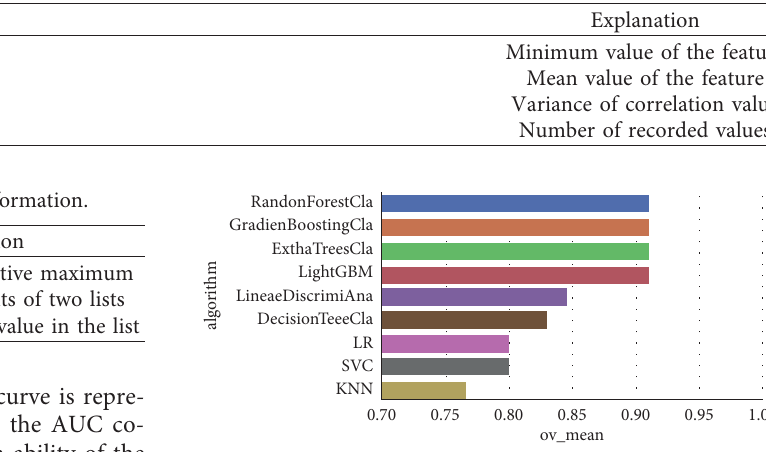
Figure 3: Base model performance